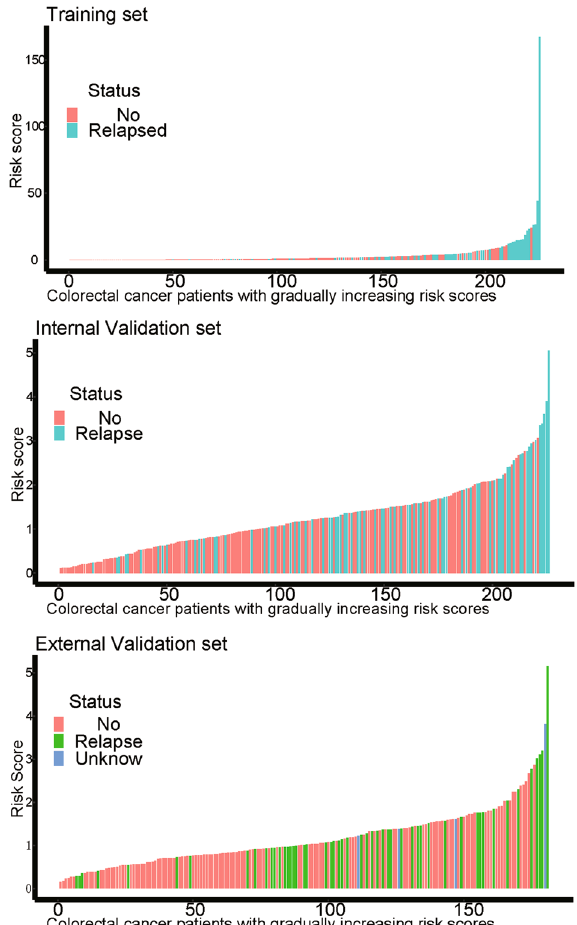
Figure 4. The distributions of RFS status and risk score in the training (n = 226, GSE31210) internal validation (n = 226, GSE30219) and external validation (n = 181, GSE50081) sets. The results showed that patients with recurrent NSCLC had a high risk score. Abbreviation: RFS, disease-free survival.